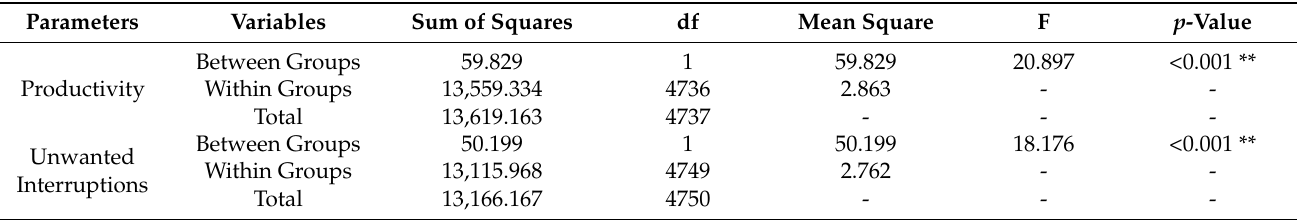
Table 5. One-way ANOVA analysis comparing productivity and unwanted interruptions in commercial and institutional building groups.